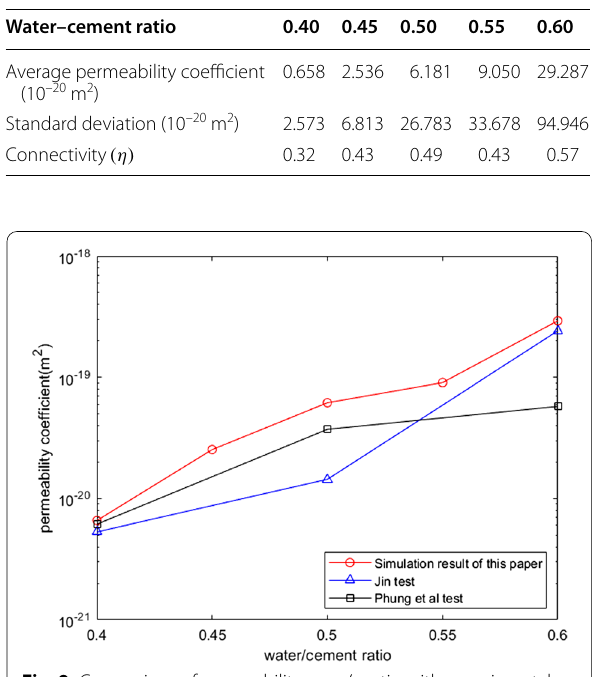
Fig. 10 Comparison of water permeability coefficient vs. hydration time with the experimental